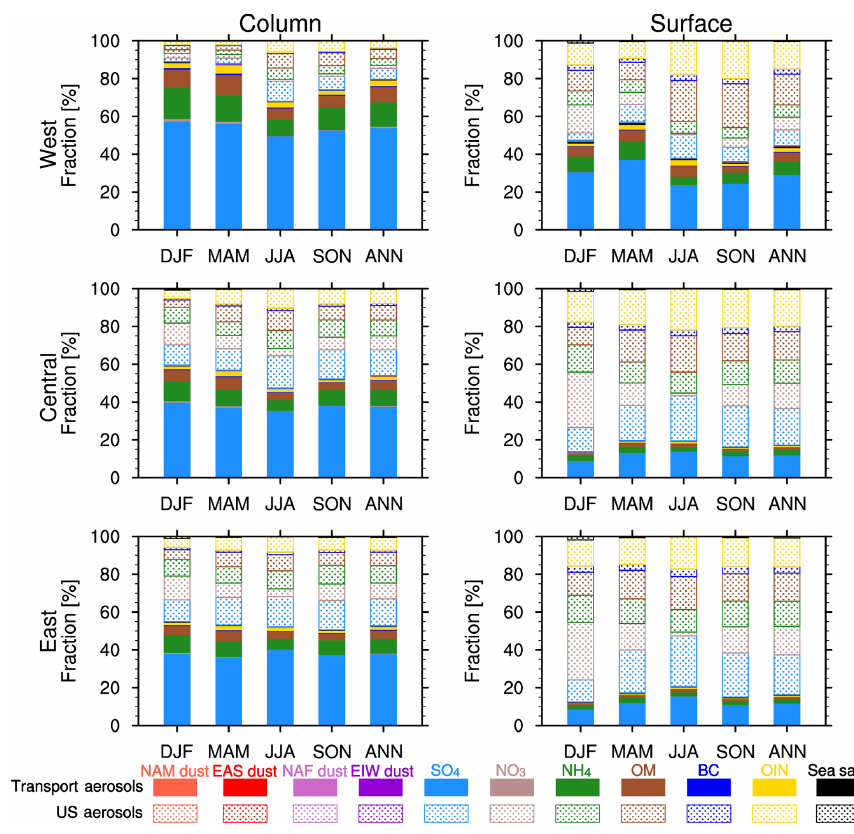
Figure 14. Same as in Fig. 13 but for aerosol number